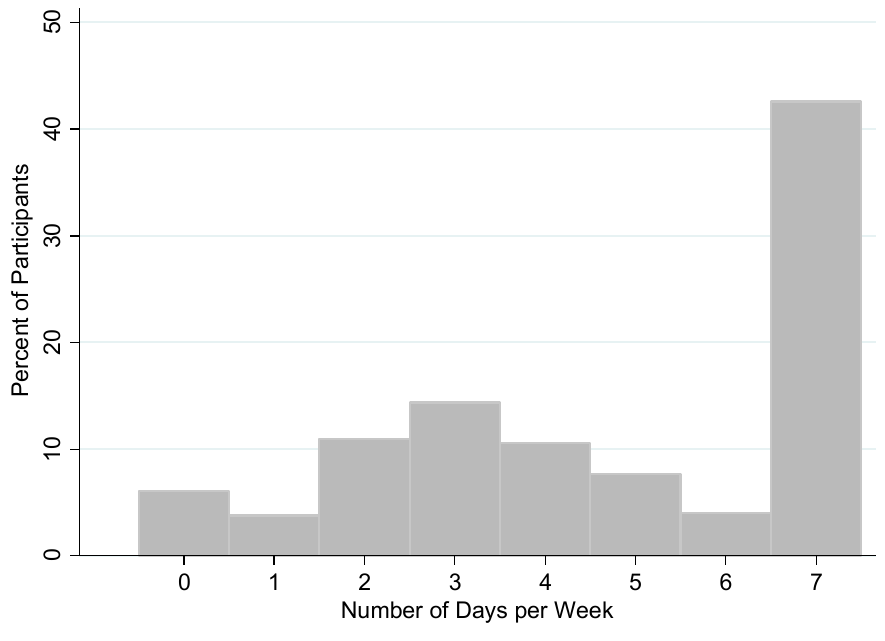
Figure 3. Weekly consumption of sugar-sweetened beverages among study participants. Table 5. Associations between sociodemographic characteristics and number of days per week consuming sugar-sweetened beverages among the study population.